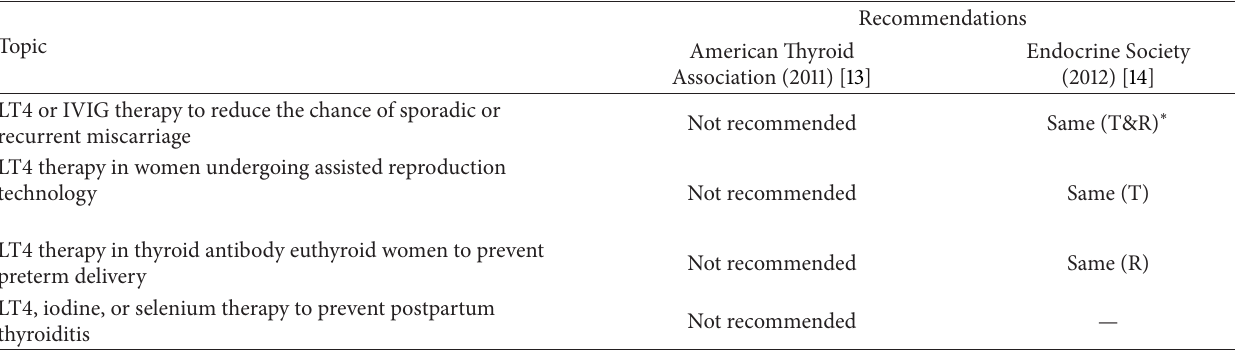
Table2:ComparisonofrecommendationsofAmericanThyroidAssociation[13]andEndocrineSociety[14]ontheaspectsoftreatingthyroid antibody euthyroid women in